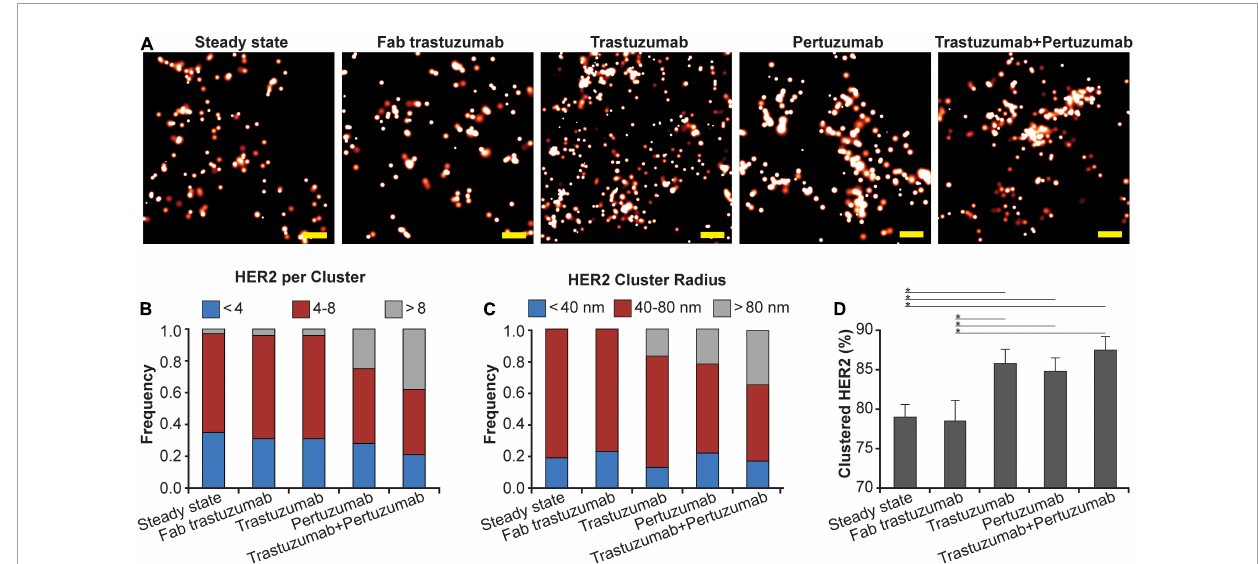
FIGURE1 Effect of mAbs on HER2 nanoscale organization. (A) SMLM images of HER2-paGFP within a region from MDA-MB-468 cells in steady state and upon mAb/Fab treatment. An example for steady state HER2 is shown on the left, and examples for the organization of HER2 upon 10-min treatment with 20 nM Fab trastuzumab, 10 nM trastuzumab, 10 nM pertuzumab, and co-treatment with 10 nM trastuzumab and 10 nM pertuzumab are shown from left to right. All treatments were performed at 37 ◦ C. Scale bars: 200 nm. Standard PALM image analysis was employed (68) and localizations were grouped using a maximum blinking time of 5 s for paGFP and group radius of three times the maximum localization precision. (B) Distribution of detected HER2-paGFP molecules per cluster in steady state and upon mAb treatment. (C) Distribution of cluster radius of HER2-paGFP in steady state and upon mAb treatment. (D) Fraction of clustered HER2-paGFP molecules with SEM; *denotes p value ≤ 0.05. Quantitative analysis (B–D) was based on the following cell and region of interest (ROI) statistics: steady state (12 cells, 26 ROI), Fab trastuzumab (12 cells, 26 ROI), trastuzumab (13 cells, 30 ROI), pertuzumab (13 cells, 36 ROI), and co-treatment with trastuzumab and pertuzumab (12 cells, 29 ROI). ROIs for analysis were 10-18 µ m 2 . While Fab trastuzumab had minimal effect on the HER2 distribution, mAbs and mAb combination induced significant